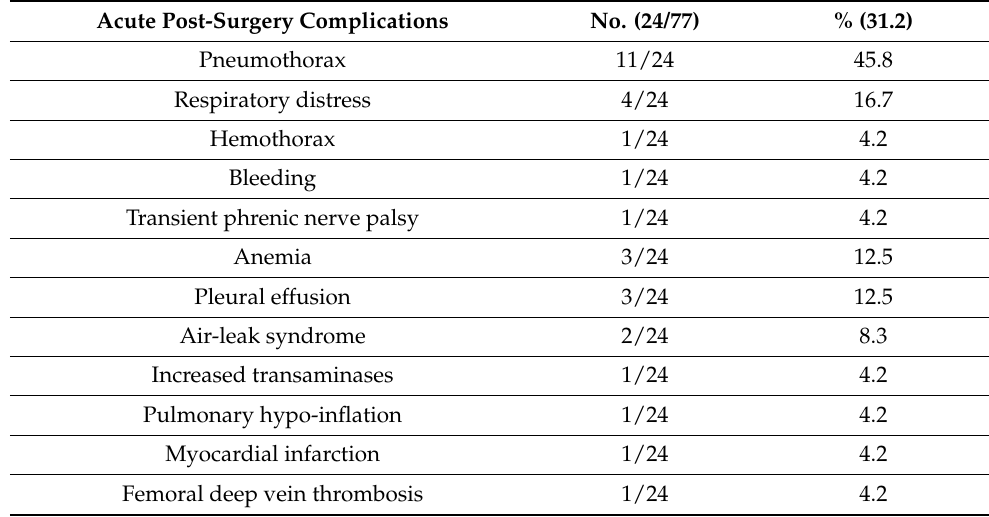
Table 1. Short-term post-surgery complications. Acute Post-Surgery